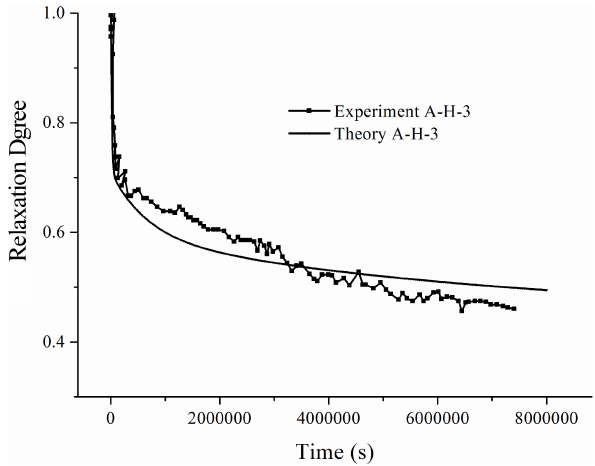
Figure 13: Comparison of preload relaxation for